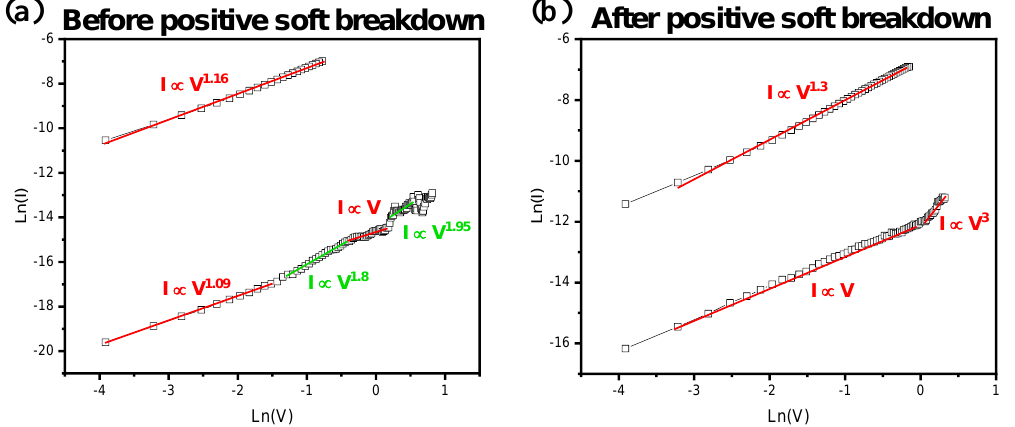
Figure 5. Ln(I) versus Ln (V) for ( a ) before positive soft breakdown (PSB) and ( b ) after PSB. Figure 6 revealed that the PSB behavior appeared even in pulse mode. As illustrated in Figure 6a, where a set voltage − 1.5 V is applied at 100 µ s of pulse width in an initial state, a current is not changed; however, where − 2 V is applied, the current is increased up to 220 µ A; then, the current is reduced by applying a reset voltage of 2 V (Figure 6b). Figure 6c,d shows the transient characteristics after the PSB operation. It can be seen that the current increases at a voltage of − 2 V or higher before PSB, whereas the current is converted from HRS to LRS even when the set pulse of − 1.5 V is applied and the conversion from HRS to LRS is performed. When a positive voltage of 3 V is applied as a pulse width of 1 ms, the current falls and then rapidly increases, resulting in the formation of a conductive filament (Figure 6e). Figure 6f,g depicts a comparison of the pulse endurance properties before and after the PSB. Prior to the PSB (Figure 6f), when the set/reset pulses of − 2 V/100 µ s and 2 V/100 µ s were applied 10,000 times, the HRS current surged at the end and the switching failed. On the other hand, after the PSB (Figure 6g), the cycle was repeated over 100,000 times with a set pulse of − 1.5 V/100 µ s, which can be shown to be measured similarly to the DC endurance characteristic.